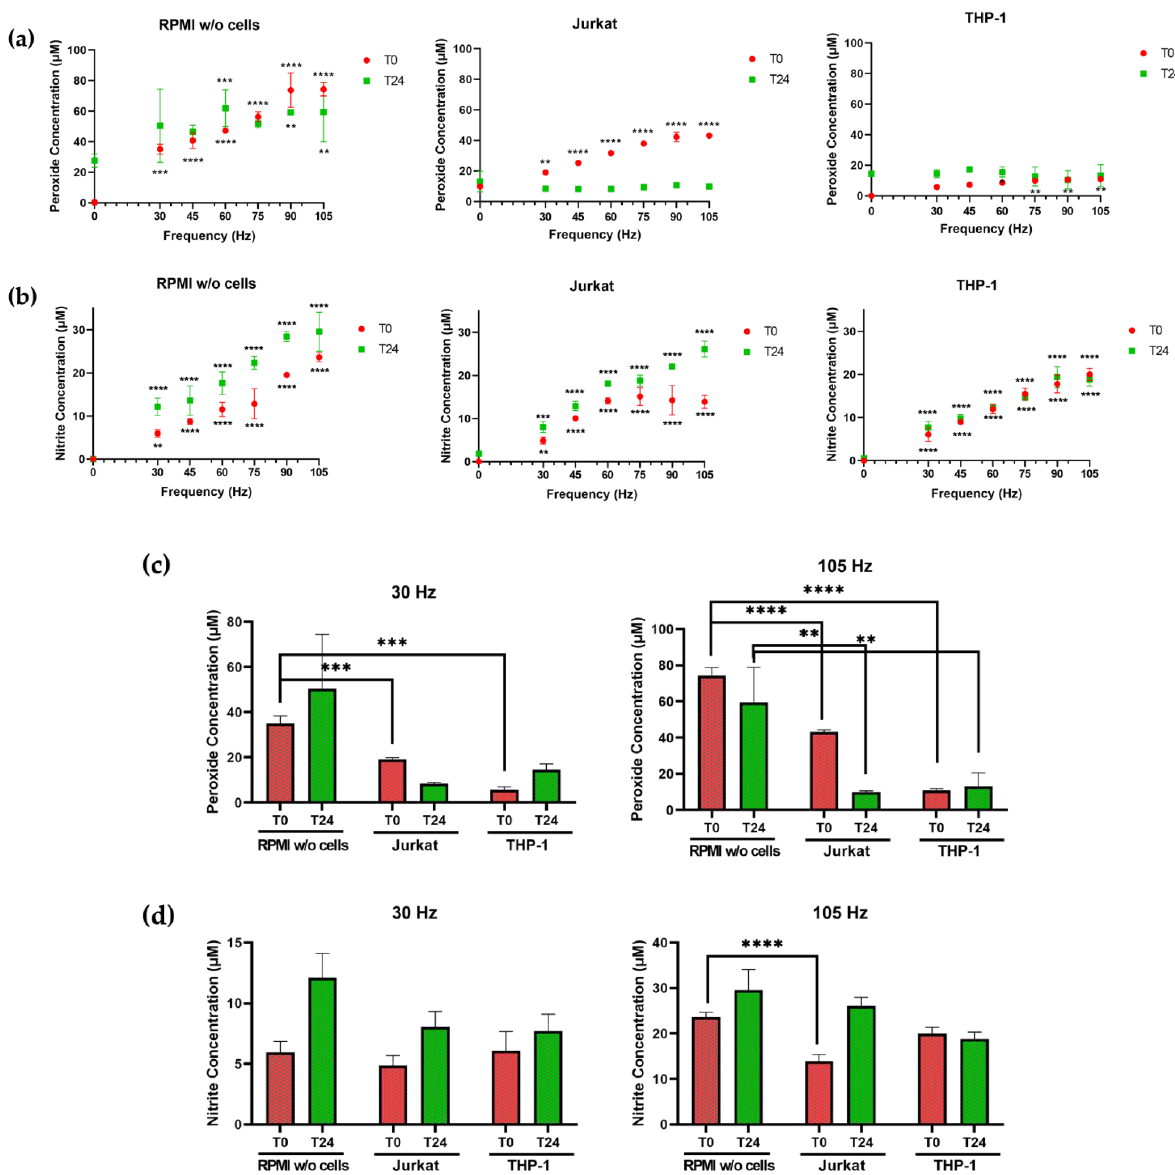
Figure 2. Jurkat or THP-1 cells alter the RONS composition of NTP-exposed media. ( a ) Hydrogen peroxide concentration in RPMI in the absence of cells or containing Jurkat or THP-1 cells and ( b ) nitrite concentration in RPMI without cells or containing Jurkat or THP-1 cells immediately (T0—red) and 24 h (T24—green) after NTP exposure. ( c ) Hydrogen peroxide concentration is lower in the presence of Jurkat or THP-1 cells both at 30 Hz and 105 Hz at T0 and T24 after NTP exposure. ( d ) NTP exposure of RPMI in the absence of cells results in a higher concentration of nitrite in RPMI in the absence of cells than with Jurkat cells, immediately following 105 Hz exposure. Data are presented as mean ± SD from one experiment (n = 3). Significance was calculated using an unpaired Student’s t -test (** p < 0.01, *** p < 0.001, **** p < 0.0001).